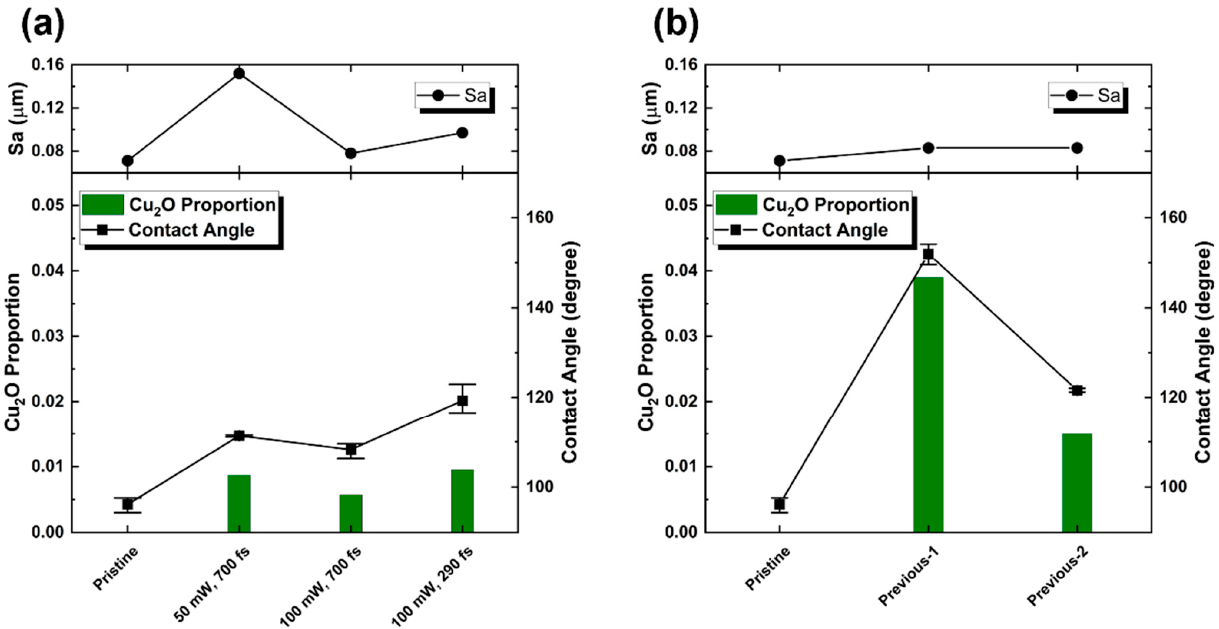
Figure 6. Contact angle, Sa, and Cu 2 O proportion of the pristine and laser ‐ irradiated samples. ( a ) 4 mm × 4 mm samples. ( b ) Previous sample with different experiment dates of CA and XRD. The droplets used for the CA measurement have a volume of 3 μ L. The CAs were automatically confirmed by pre ‐ installed software which can automatically detect the edge of droplets.